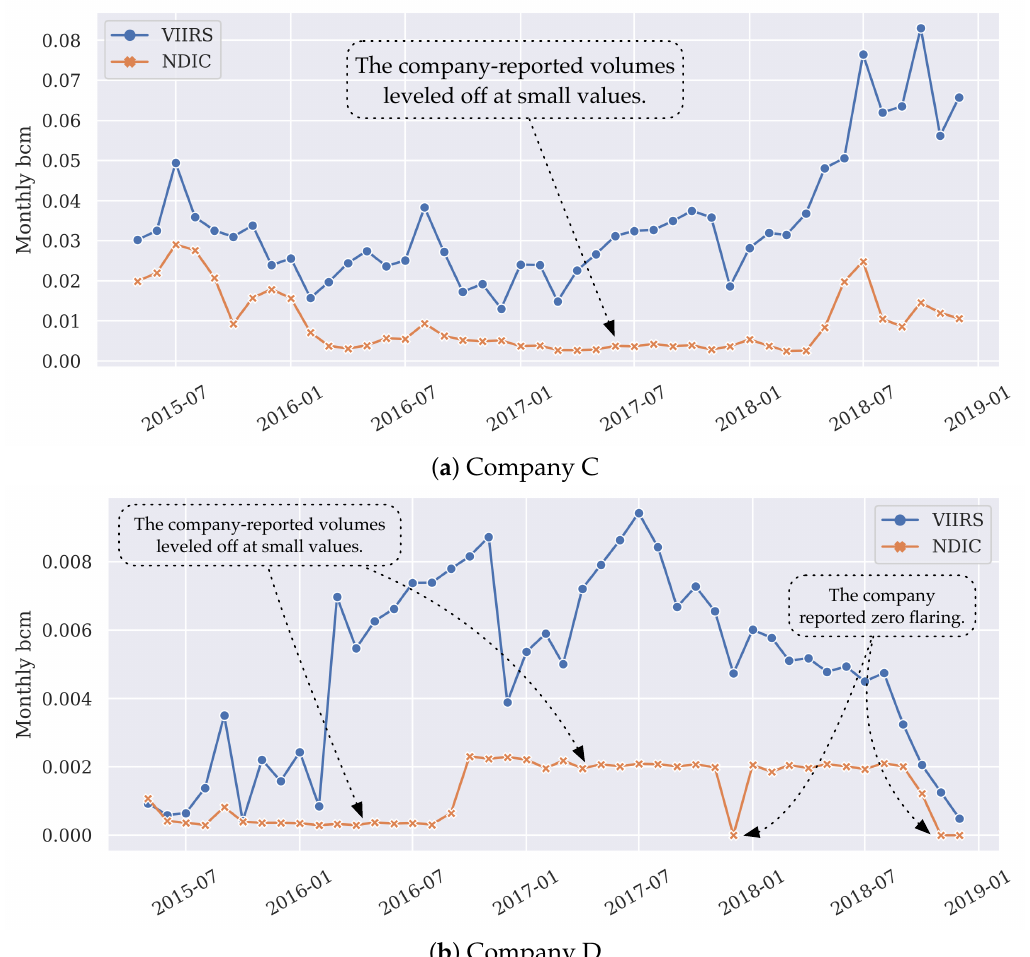
Figure 25. Time series of the two example companies whose reporting show discrepancies with the VIIRS records. The times during which the company-reported data were significantly different from the satellite detections are